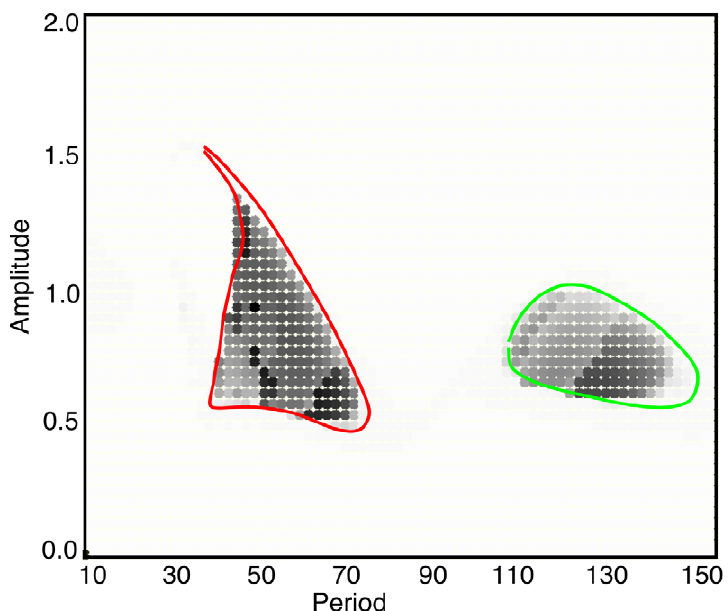
Figure 3. ‘‘Phase-diagram’’ for the one-dimensional spatial model. Each point represents a simulation at a fixed value of the amplitude and period for the flashing stimulus. The gray-scale represents the magnitude of the pattern averaged over time. Specifically, the time average of D ( t ) : ~ P 100 D U e ( i , t ) { U e (50, t ) D is plotted. If there is a spatially homogeneous pattern, D ( t ) ~ 0 . The curves super-imposed on the diagram represent i ~ 1 regions where the homogeneous state is shown to be unstable.